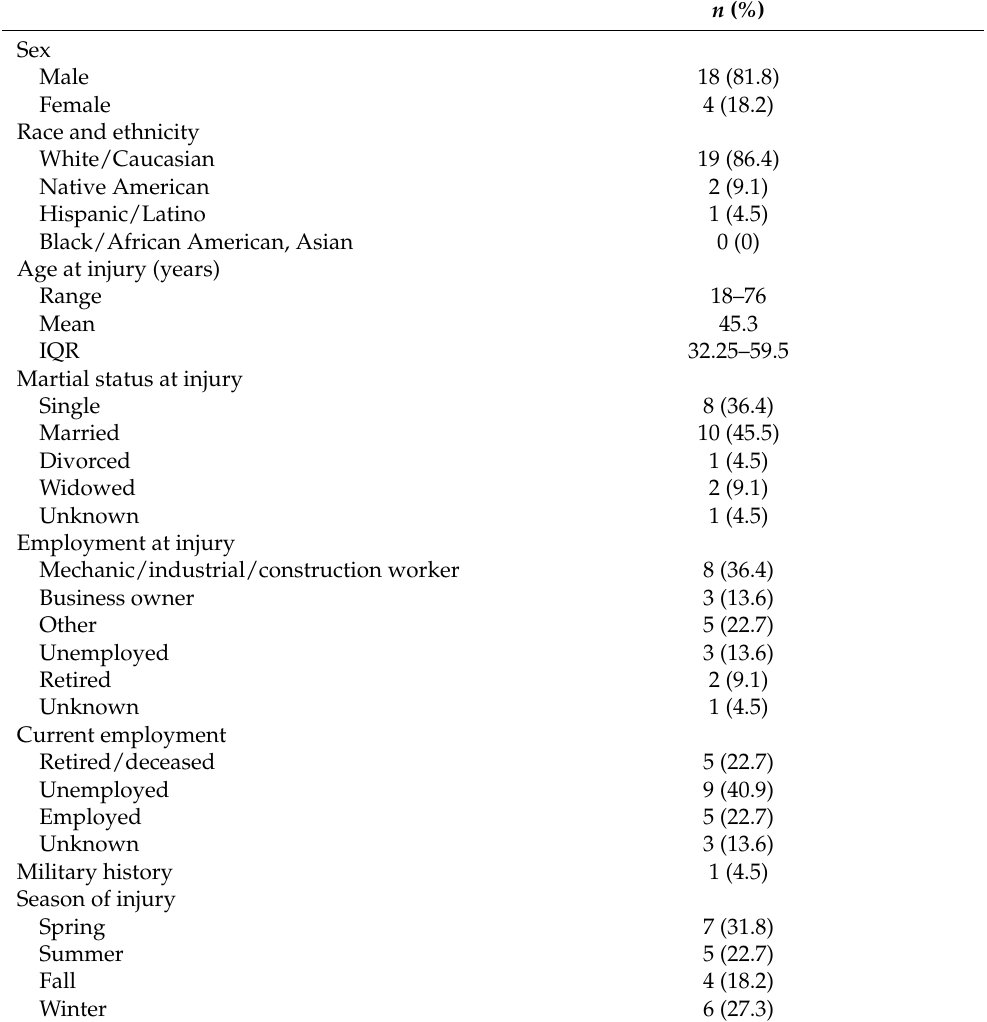
Table 1. Patient characteristics (N = 22).